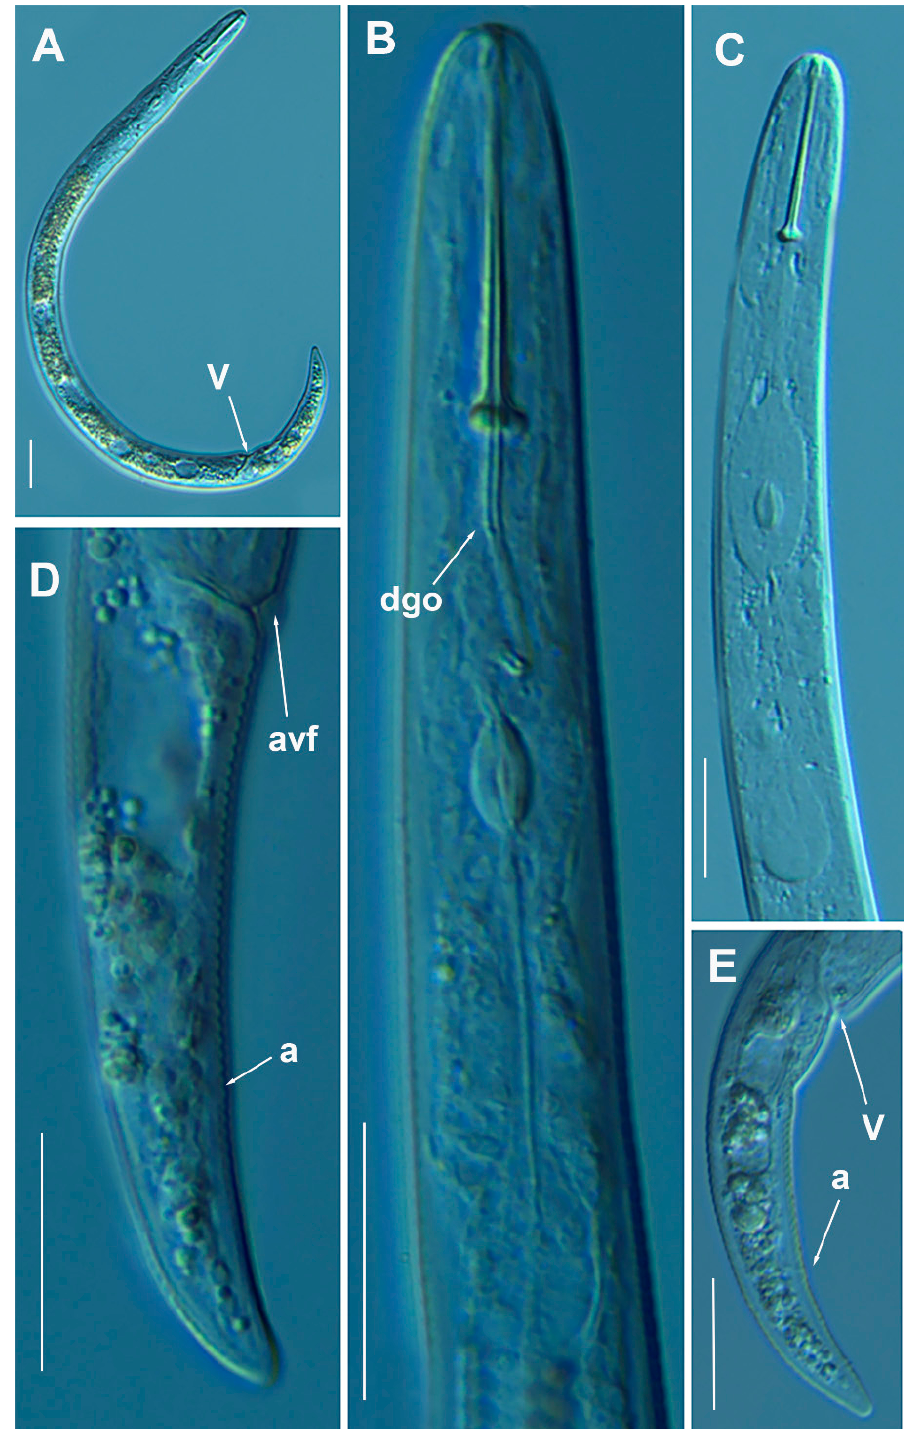
Figure 12. Light photomicrographs of Paratylenchus enigmaticus Munawar, Yevtushenko, Palomares- Rius & Castillo, 2021. ( A ): Entire female with vulva arrowed; ( B , C ): Female pharyngeal region; ( D , E ): Female posterior region showing vulva and anus (arrowed). Scale bars ( A – E = 20 µ m). (Abbreviations: a = anus; avf = advulval flap; dgo = pharyngeal dorsal gland orifice; V=